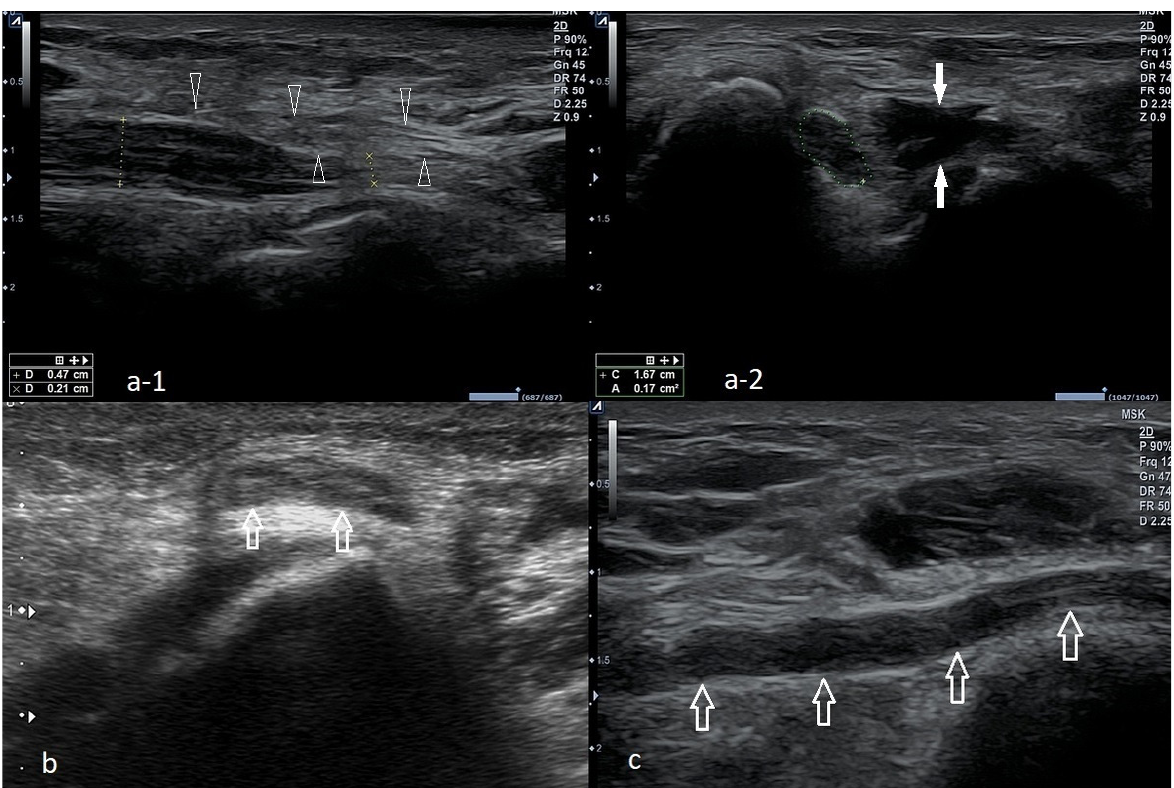
Figure 9. Three cases of the ulnar nerve neuropathy of different etiologies. ( a-1 )—Long-axis view of the ulnar nerve, visible compression of the nerve at the level of the arcuate ligament (the narrowing of the nerve is accompanied by increased echogenicity); proximal to the stenosis site, nerve swelling is visible, expressed as a thickening, decreased echogenicity without the typical echo structure. Ar- rowheads—Osborn’s ligament transforming into an arcuate ligament in the distal direction. ( a-2 )— The same case, cross-section at the level of the sulcus, significantly increased cross-sectional area (0.17 cm 2 , with the norm defined by most authors at 0.09 cm 2 ), although in the longitudinal section, a nerve compression is visible at the level of the arcuate ligament; in this case, at the level of the sulcus there is also a visible muscular structure that may correspond to the anconeus epitrochlearis (marked with white arrows). ( b )—A case of instability of the ulnar nerve, during flexion above 90 degrees: the ulnar nerve (arrows) was dislocated above the surface of the medial epicondyle. ( c )— Significant nerve swelling, mainly at the level of the sulcus; no stenosis was visualized at any of the levels.